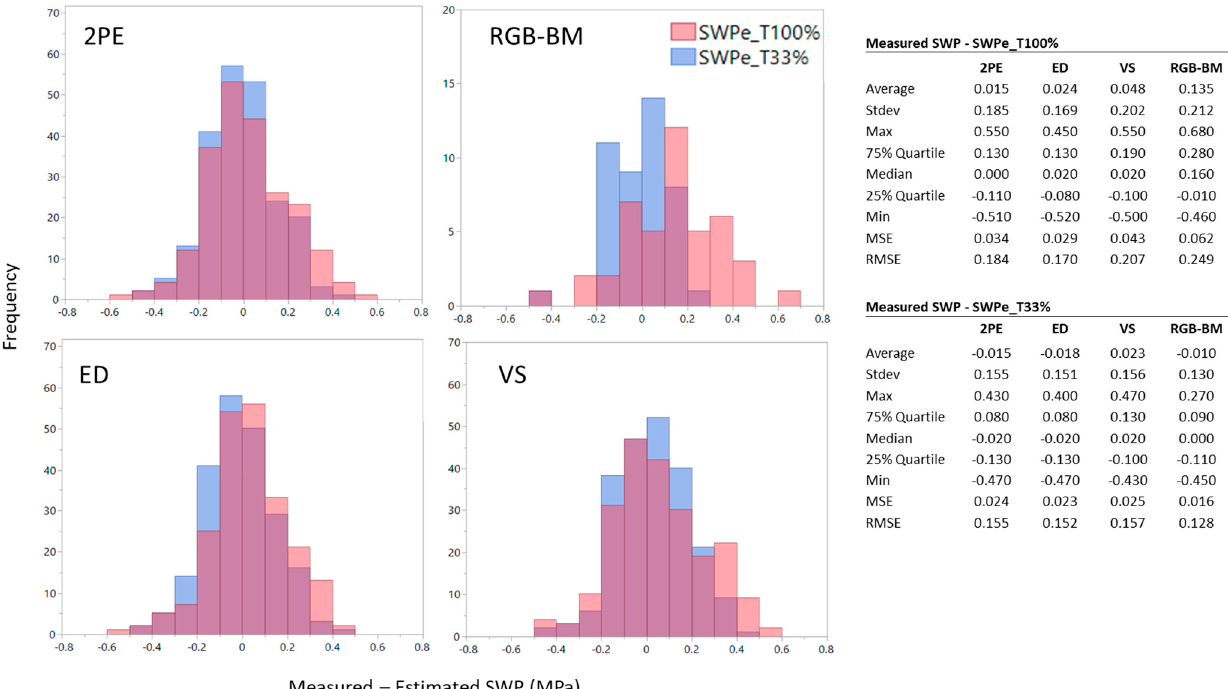
Figure 9. The histogram of the difference between the measured and estimated stem water potential (SWPe) calculated using the canopy temperature data of the average 100% (SWPe_T100%) (pink bars) and the average of the coolest 33% (SWPe_T33%) (blue bars) of canopy pixels for the 2-pixel erosion (2PE), edge detection (ED), vegetation segmentation (VS), and RGB binary masking (RGB-BM) canopy extraction methods. The frequency refers to the number of management cells (MC). The table insert provides the descriptive statistics of each dataset. Note: the Y-axis range of the RGB-BM method is specifically different from the other methods.